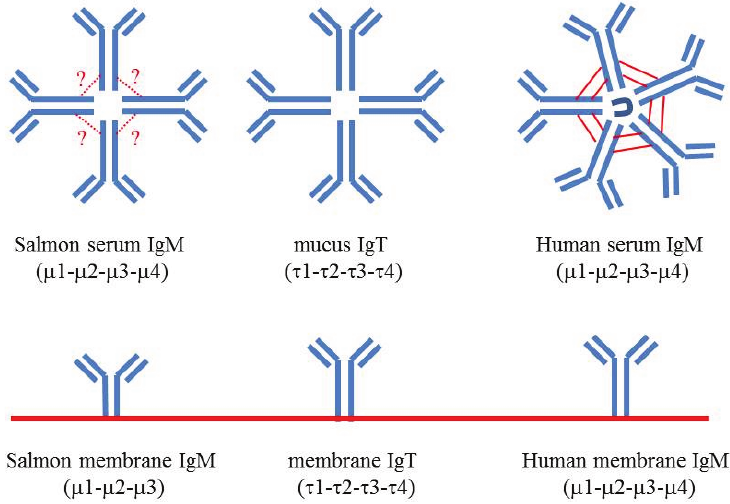
Figure 1. Schematic overview of secreted and membrane anchored IgM and IgT of salmonid fish, compared with human IgM. Serum IgM is a tetramer in teleosts. In contrast to the IgM pentamer in mammals, the monomer units in teleost IgM are loosely linked by disulfide bonding, and the J chain is lacking. Membrane anchored IgM in teleosts is one domain shorter than in mammals as a result of a special splicing pattern which excludes the entire fourth constant domain. Salmonid IgT appears to be non-covalently bonded tetramers in mucus. The similarity between the first constant domains of IgM and IgT is relatively high (52%) in Atlantic salmon, whereas the remaining domains of the heavy chains are only 13%–24% similar